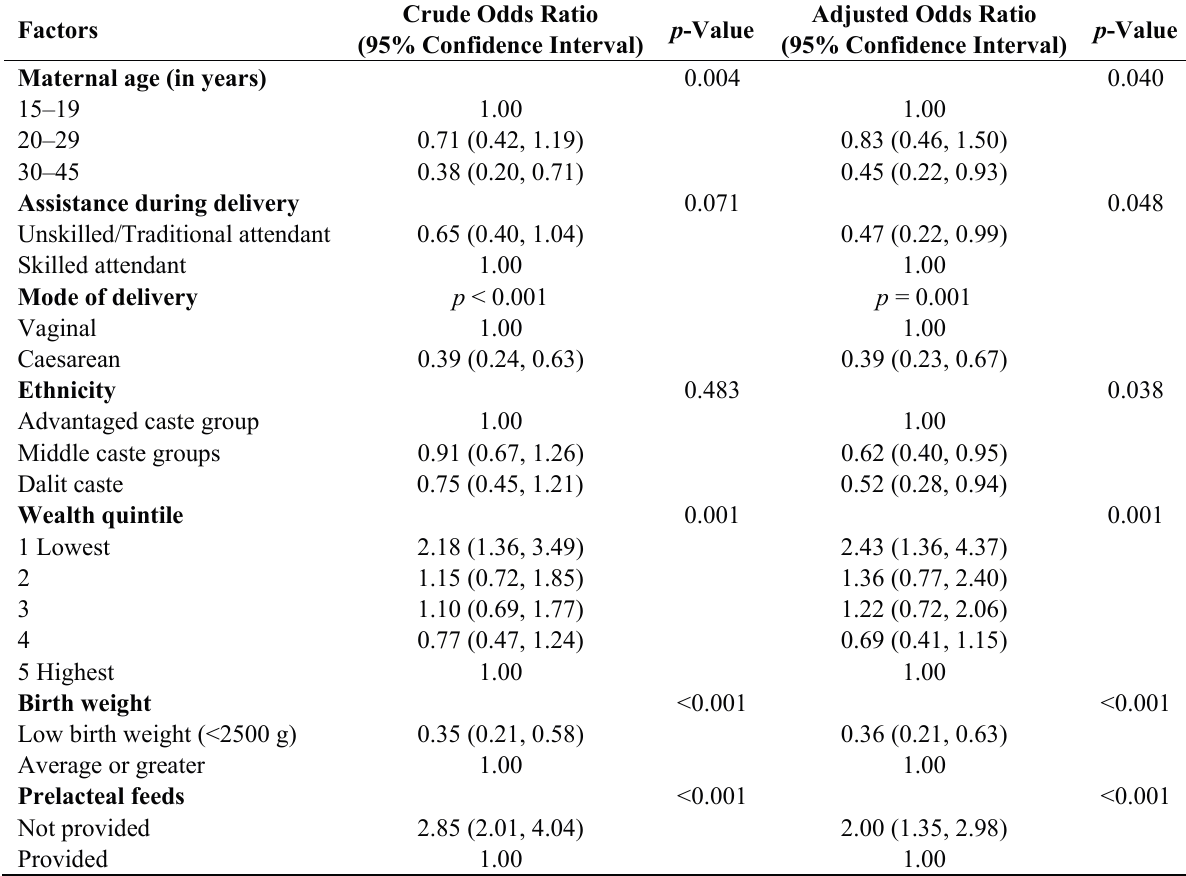
Table 2. Factors associated with early initiation of breastfeeding in Western